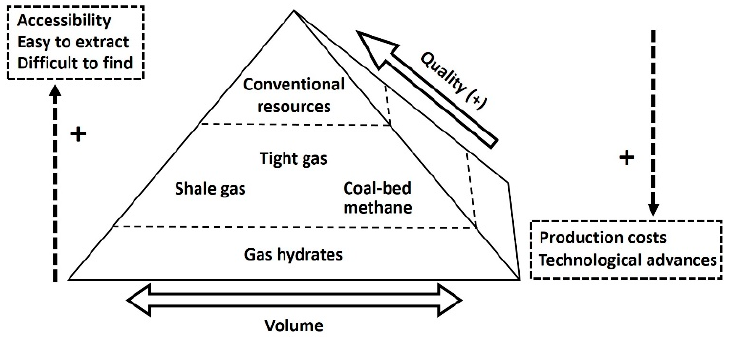
Figure 1. Pyramid of the main conventional and unconventional natural gas resources.